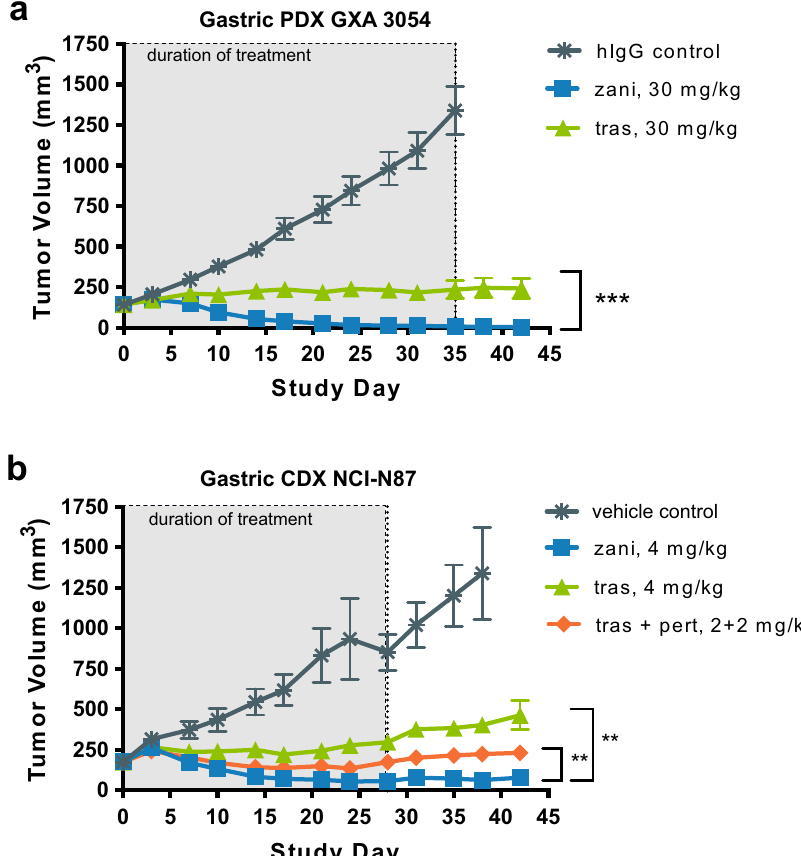
Fig.7|ZanidatamabmediatesantitumoractivityinHER2-expressingxenograft tumors. a Mean tumor volume of patient-derived gastric xenograft model GXA 3054 implanted in nude mice. Tumor bearing mice treated with indi- cated test articles at 30mg/kg, IV, twice weekly for fi ve weeks, n =10 per group. *** p value = 3.17e − 07. b Mean tumor volume of cell-derived gastric xenograft model NCI-N87 implanted in nude mice. Tumor bearing mice treated with; single agent zanidatamab or trastuzumab at 4mg/kg; or tras- tuzumab + pertuzumab combination at 4mg/kg total (2+ 2mg/kg of each agent), IV, twice weekly for four weeks, n = 7 per group. Statistical